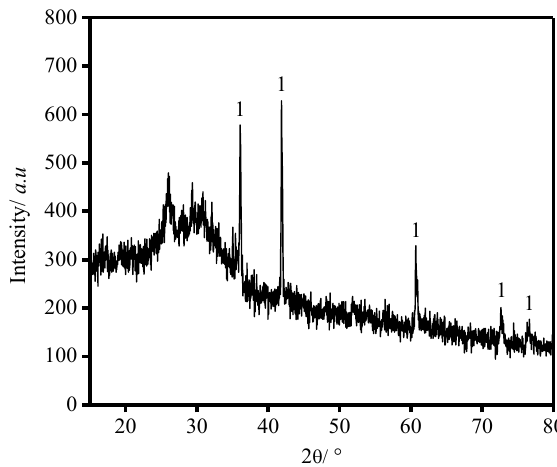
Figure 1. XRD pattern of EBFS samples. 1 = titanium carbide